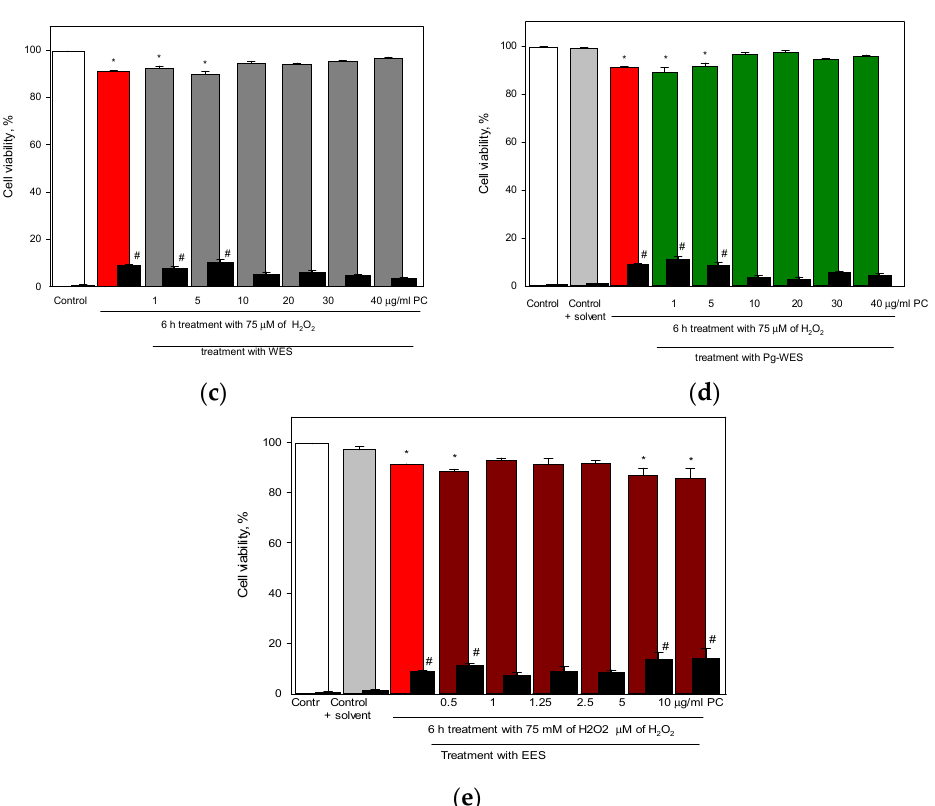
Figure 4. Effectivity of differently prepared extracts from elderflowers in sustaining the viability of glial cells under moderate oxidative stress conditions. Cells were incubated for 6 h with 75 µM H 2 O 2 or appropriate solvent (control) and additionally in the presence of various concentrations of the elderflower extracts. At the end of experiment, the cells were double-stained with Hoechst 33,342 and PI, and the viability was assessed under fluorescence microscope. Original magnification x20. For details, see the Materials and Methods section. Typical photographs of cells ( a ) Control, ( b ) 75 µM H 2 O 2 , ( c ) cell viability (%) after treatment with H 2 O 2 in the presence of WES, ( d ) cell viability (%) after treatment with H 2 O 2 in the presence of Pg-WES, ( e ) cell viability (%) after treatment with H 2 O 2 in the presence of EES. * statistically significant difference in the number of viable cells vs. solvent-only treated sample; # statistically significant difference in the number of dead cells vs. solvent-only treated sample.